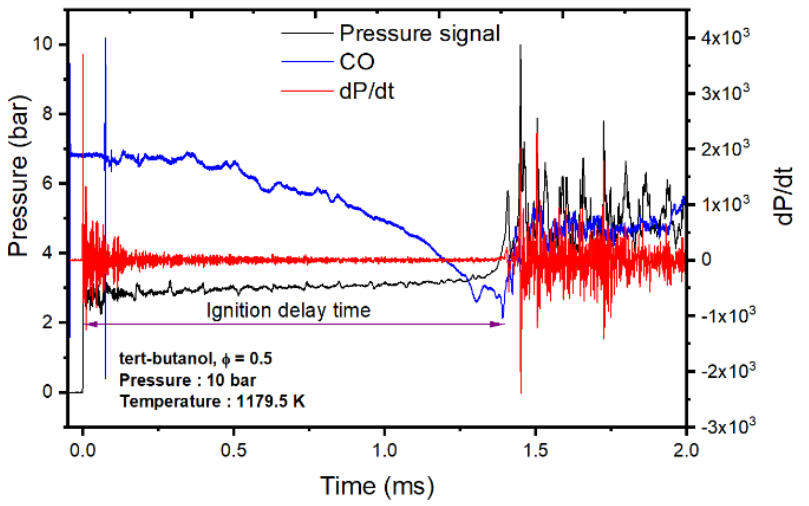
Figure 1. Typical pressure profile, pressure derivative (dp/dt) and CO absorption signal from a HPST experiment for tert-butanol.